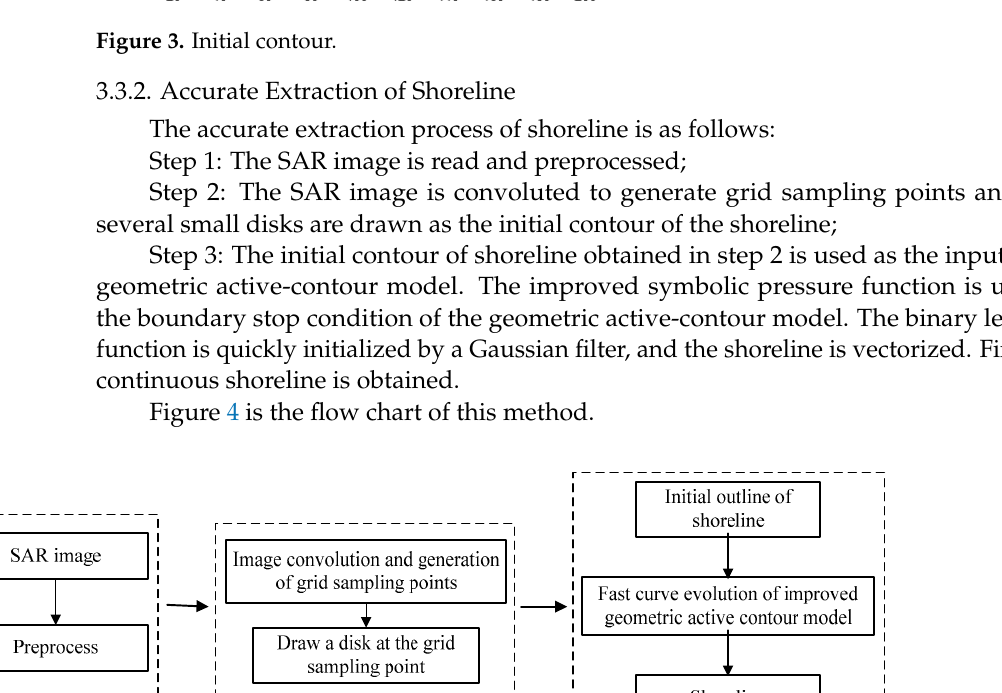
( b ) Figure 5. Synthetic aperture radar (SAR) image: ( a ) Original SAR image; ( b ) SAR image after gray transformation. In Figure 6, the shoreline is less affected by the external natural conditions, and the clarity is relatively high. The improved Canny operator method can detect continuous edge points, but there are many false detection pixels, resulting in a high error rate. The boundary-tracking algorithm and the traditional geometric-active contour model method have many false detection pixels and missing pixels, which lead to a high error rate. The method in this paper has higher accuracy and a lower error rate, and the extraction re- sults are better. See Table 1 for details.